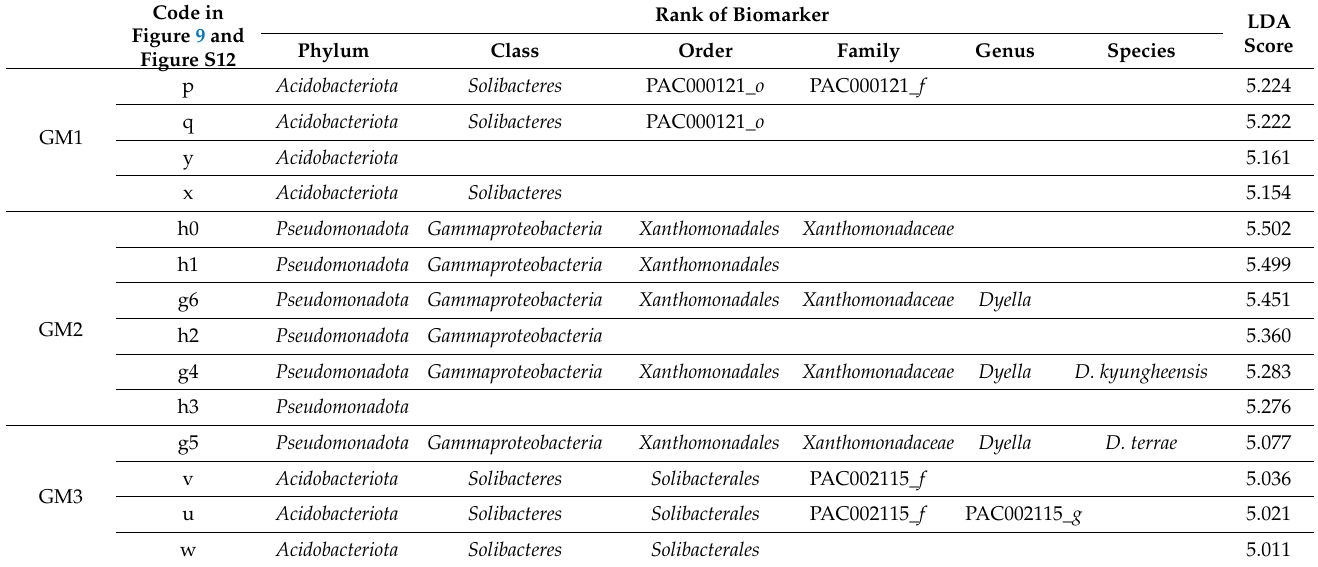
Table 4. Taxonomic biomarkers having LDA scores >5 and their corresponding codes in Figures 9 and S12. All biomarkers with LDA scores >4 are shown in supplementary Table S1.